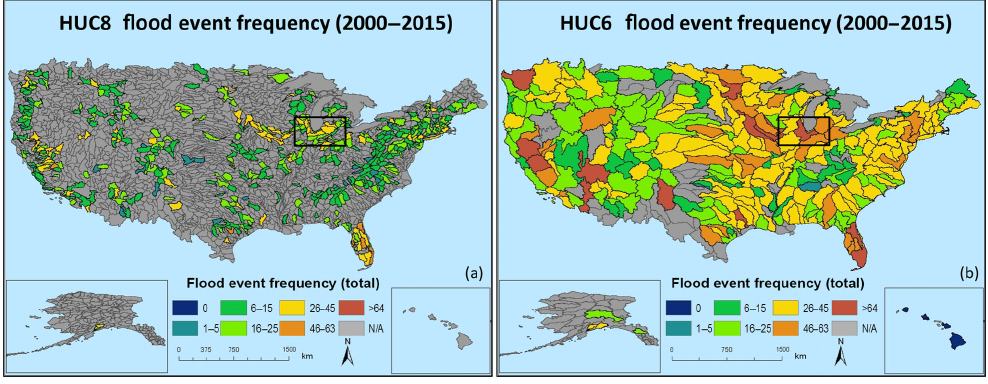
Figure 3. HUC8 and HUC6 frequency comparison, national.